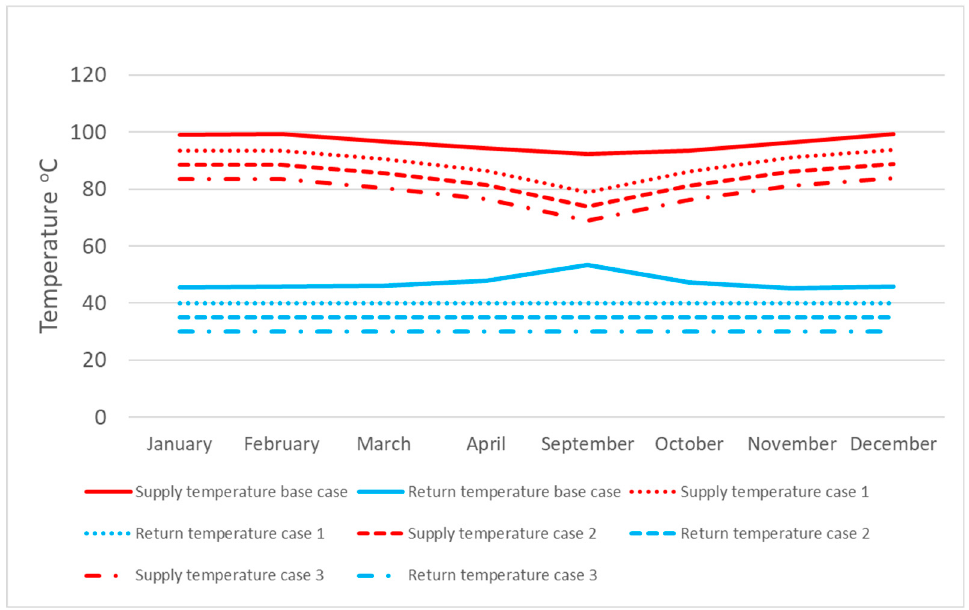
Figure 8. System temperatures in the MODEST model.